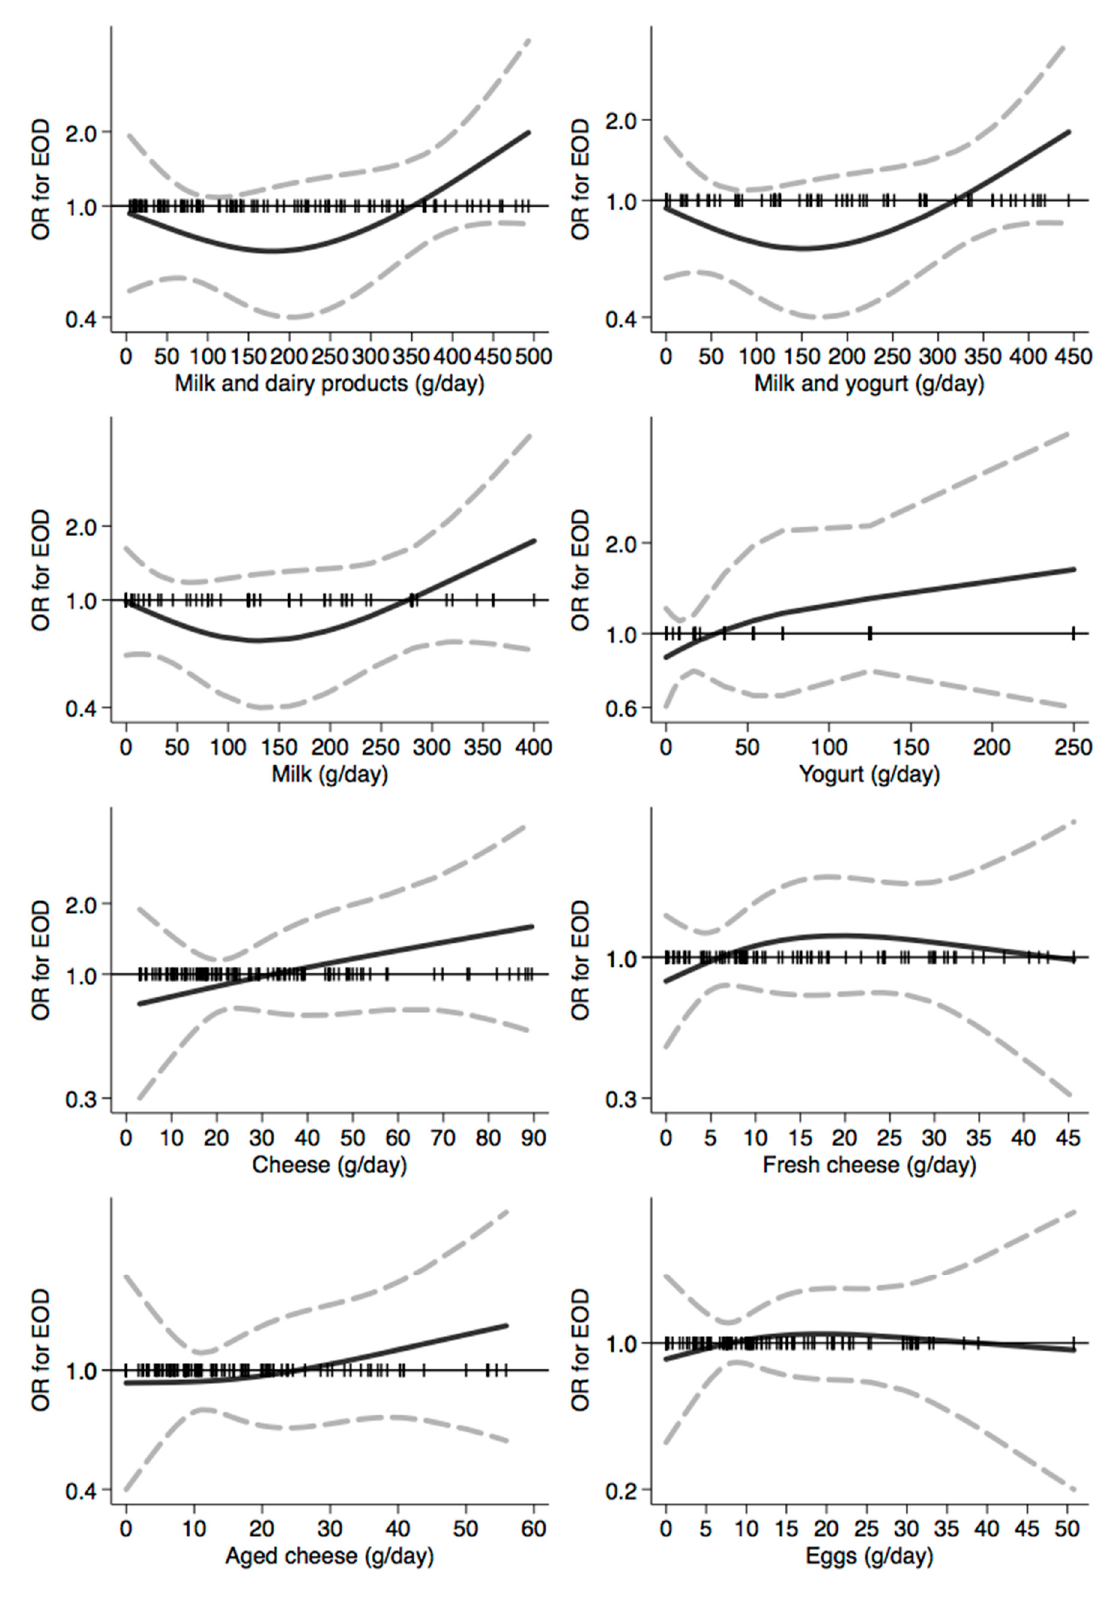
Figure 3. Spline regression analysis of early-onset dementia (EOD) risk for increasing intake of milk, dairy products, and eggs. The black line indicates odds ratios for dementia risk; dash gray lines are 95% confidence limits; the reference line at 1.0 with black spikes indicates the distribution of participant intake.